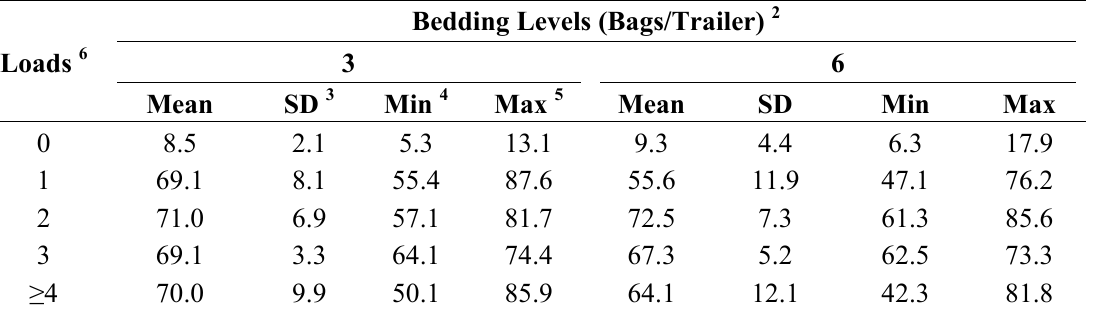
Table 4. Experiment 1. Descriptive statistics for bedding moisture (%) between 3 and 6 bags of bedding/trailer transporting market weight pigs in warm weather 1